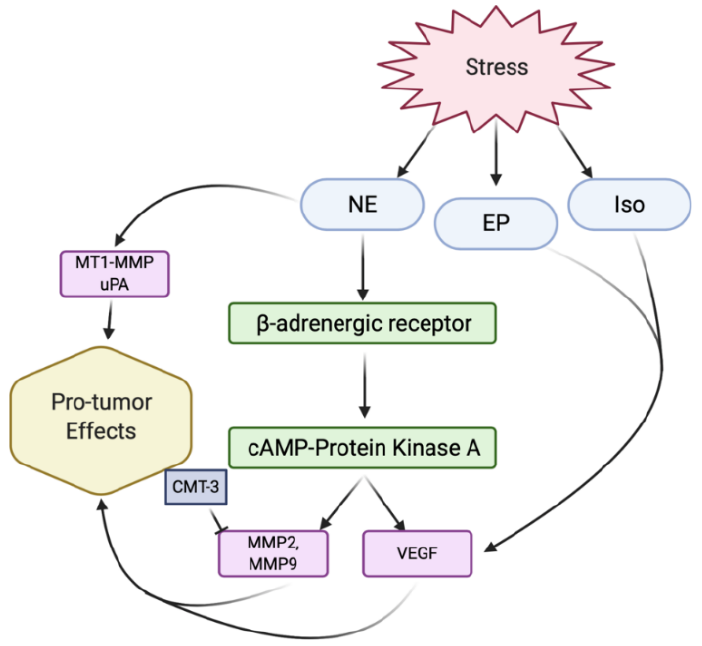
Figure 3. Relationship between stress, proteolysis, and VEGF-mediated angiogenesis. Stress induces expression of norepinephrine (NE), epinephrine (EP), and isoproterenol (Iso) [98]. NE activates β -adrenergic receptors, which activates the cyclic AMP (cAMP)- protein kinase A signaling pathway [27]. This pathway leads to an upregulation of VEGF as well as MMPs, such as MMP-2 and MMP-9 [27]. Other proteases such as MT1-MMP and uPA are upregulated by NE as well, also leading to pro-tumor effects which can be mitigated by CMT-3 [28,99]. EP and Iso have been shown to upregulate VEGF expression as well [98].